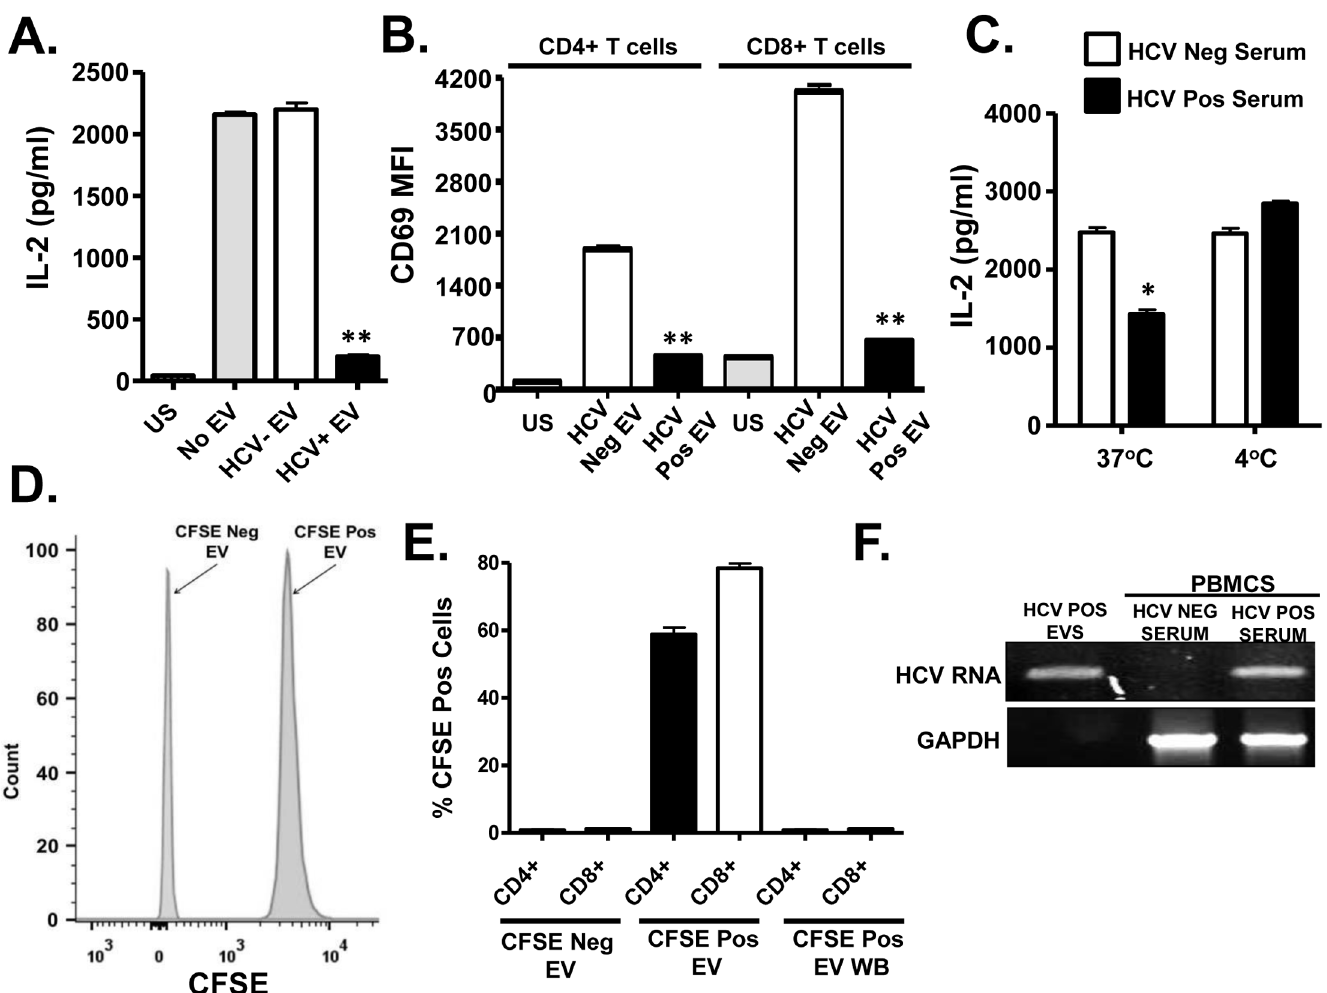
Fig 2. HCV serum derived extracellular vesicles (EV) inhibit T cell receptor (TCR) signaling in primary human T lymphocytes. Healthy donor PBMCs were incubated with pooled serum extracellular vesicles (EV) obtained from HCV-infected patient sera (HCV+ EV; GT 1, 1a, 1b, 2, 2b and 3). TCR induced IL-2 (A) and CD69 surface expression (B) was measured. TCR induced IL-2 release by human T cells incubated with HCV-positive or negative serum for two hours at 37°C or 4°C (C). Analysis of CFSE positive serum EV (D) and uptake of CFSE-positive EV by primary human T cells (E) as determined by flow cytometry. HCV RNA was detected using RT-PCR in EVs from HCV-positive serum, and in human PBMCs incubated with HCV-positive but not HCV RNA negative serum (F). HCV RNA US = unstimulated cells. MFI = mean fluorescent intensity. Data represent the average of three technical replicates, and the standard deviation is shown. Each experiment was independently performed with three different donors with similar results. * P < 0.05; ** P <